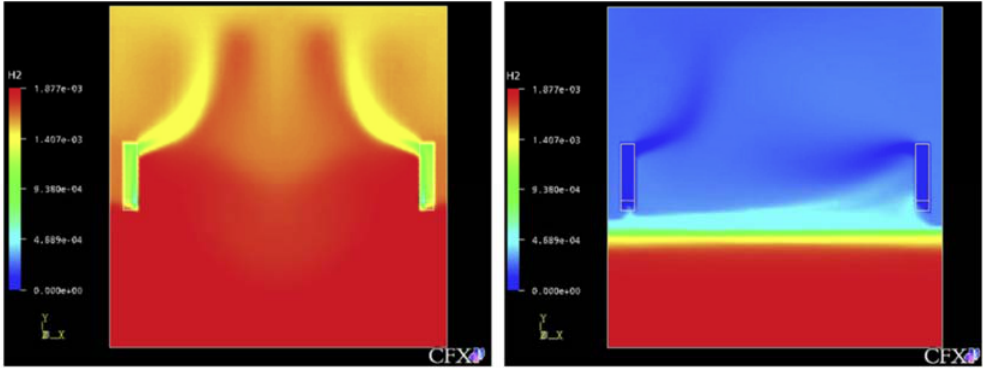
Figure 1. Hydrogen stratified by the PAR’s activation, (numerical simulation by Reinecke at al.).